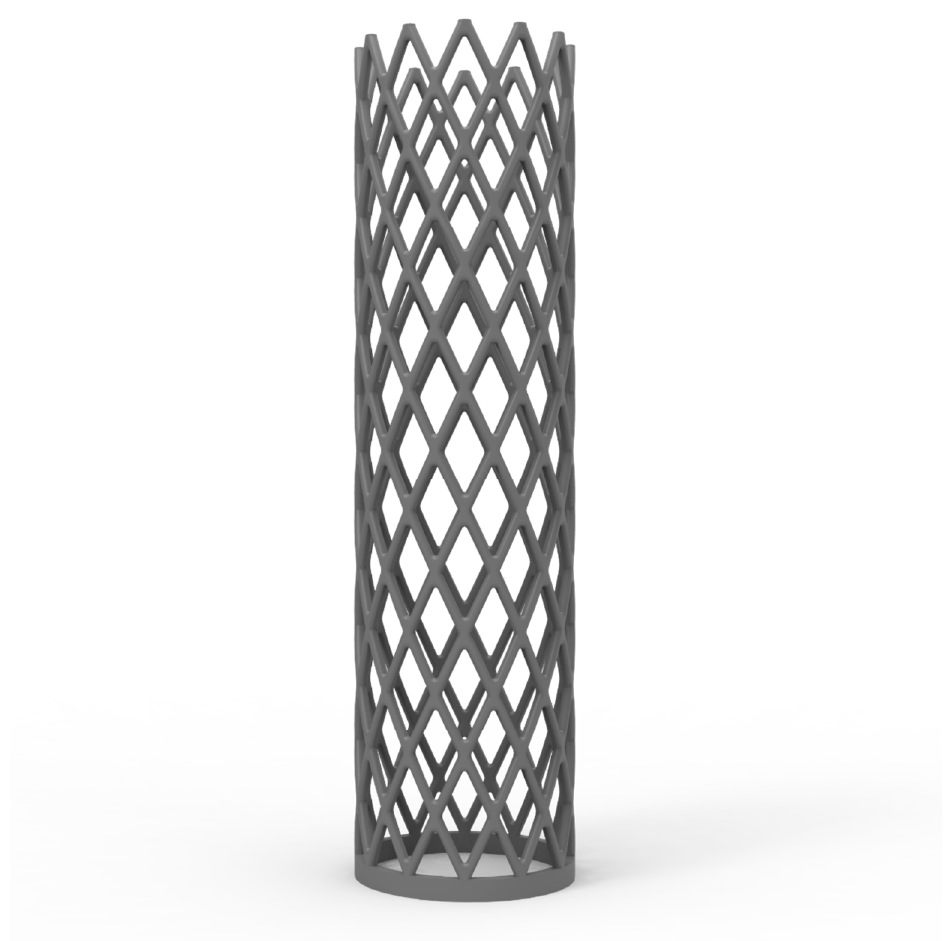
Figure 4. Rendering of the net structure with homogenized nodes through rounding from CAD.